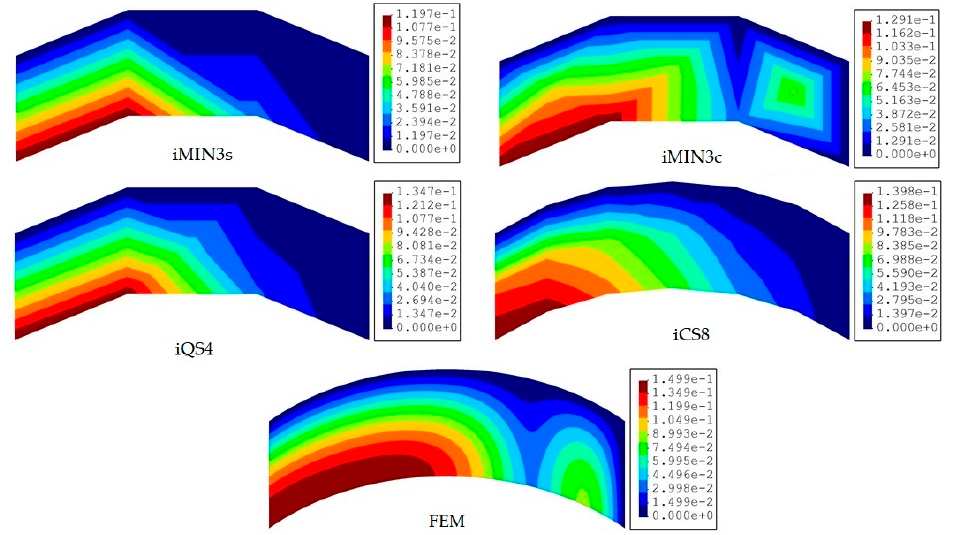
Figure 8. Contours of total displacement [mm] obtained from iFEM (coarse mesh) and high-fidelity FEM analyses for the curved plate.